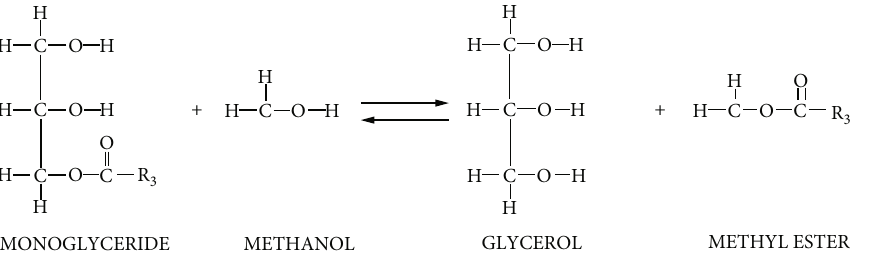
Figure 2: The chemical reaction in transesteri fi cation. Table 1: Fuel properties of di ff erent blends. S.